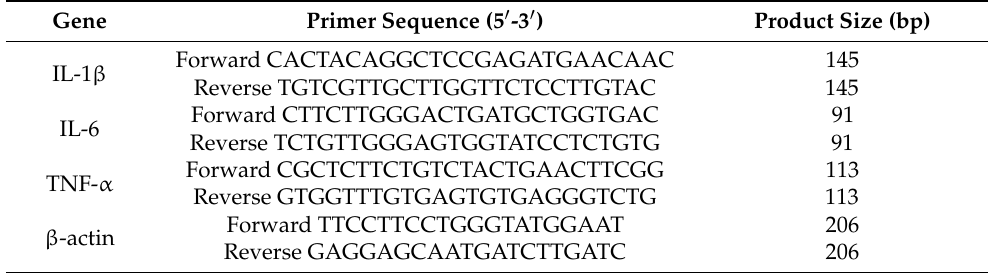
Table 1. Primer sequence